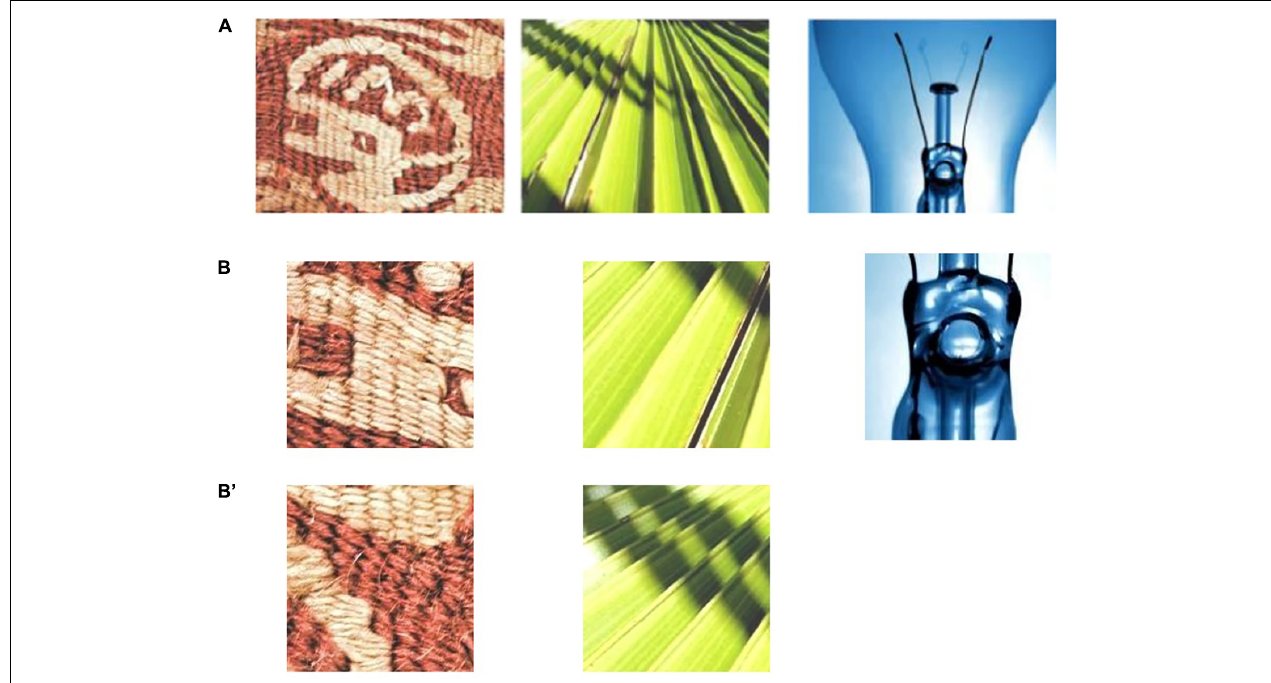
FIGURE 1 | (A) Examples of FMD images and (B,B (cid:48) ) examples of extracted FMD texture images.